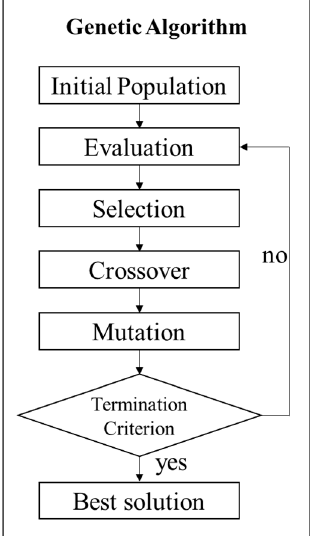
Figure 5. Flowchart of GA for inverse reconstruction of stiffness matrix.